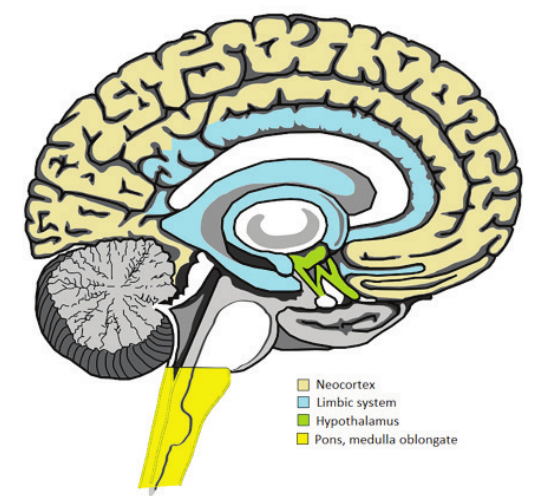
Figure 1: Brain regions involved in food intake regulation (Human hemisphere, midsagittal view).